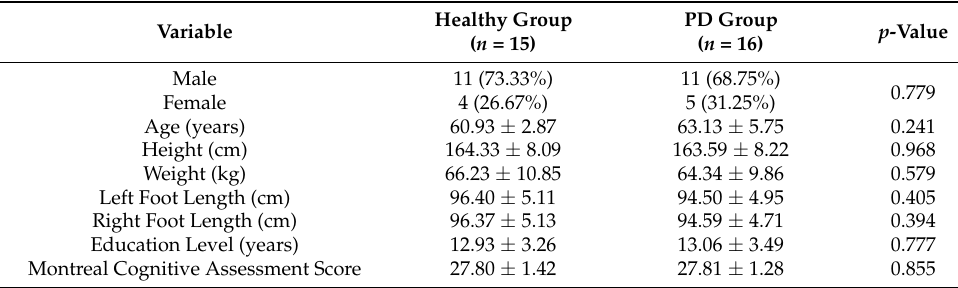
Table 1. Characteristics of the 31 patients with or without Parkinson’s.